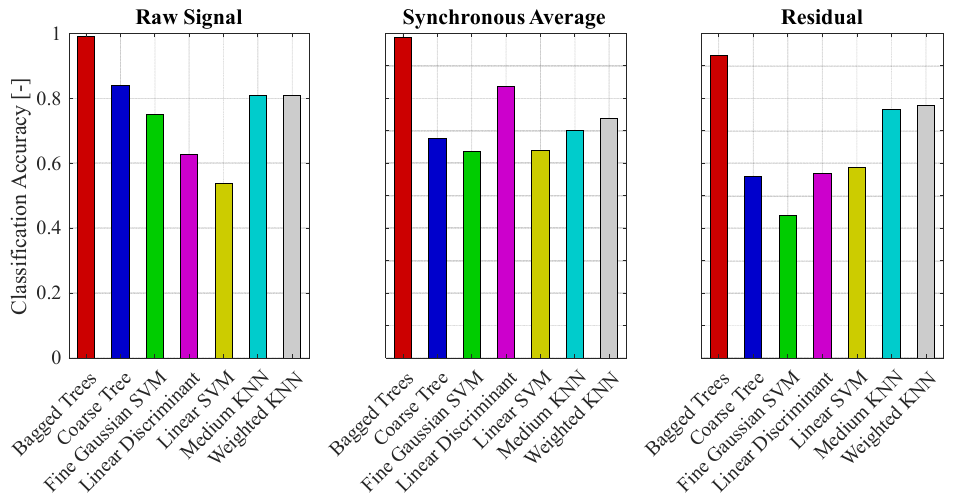
Figure 14. Classifier accuracy of raw signal with sensor 1 and sensor 2 (50 features).